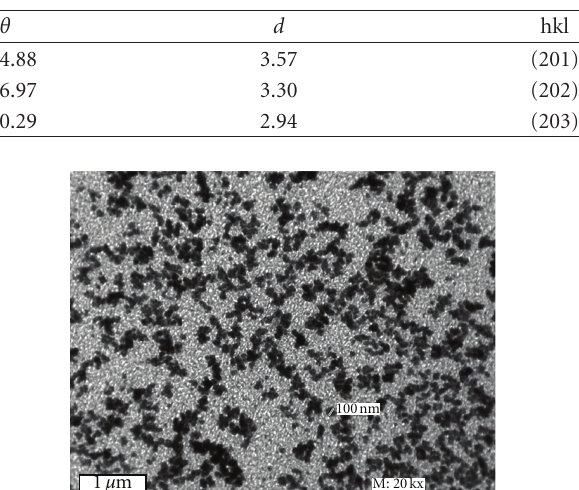
Figure 3: TEM image of 4,9,10-perylene-tetracarboxylicacid- diimide, PTCDI,